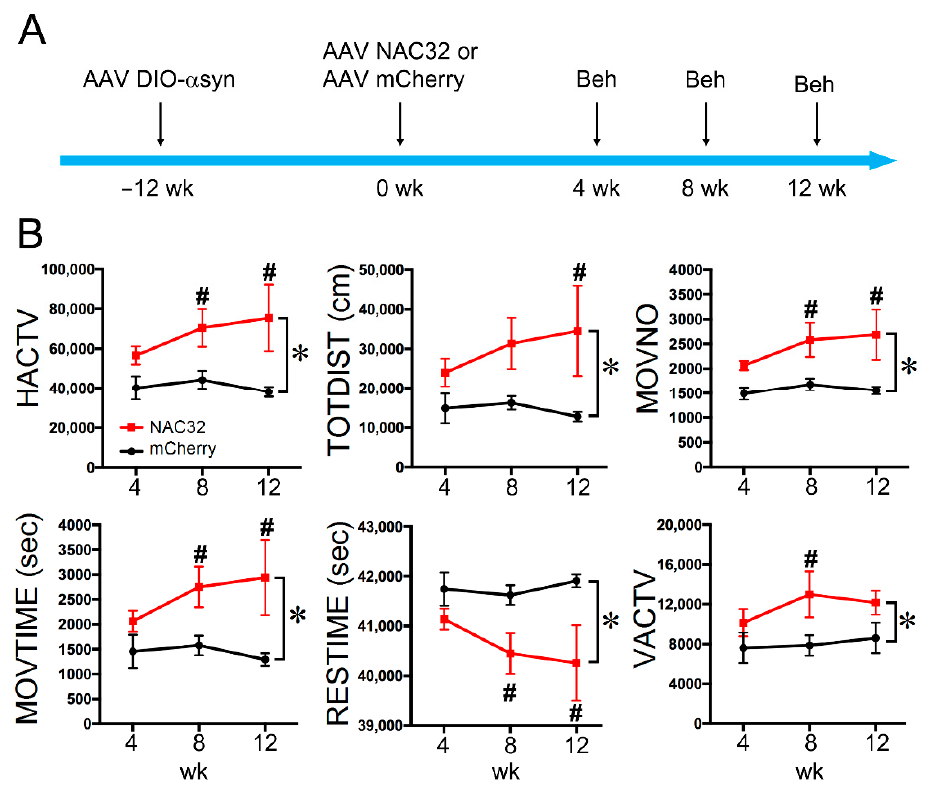
Figure 6. Intranigral administration of AAV-NAC32 normalized locomotor behavior in animals overexpressing α Syn. ( A ) Timeline of experiment. AAV-NAC32 or AAV-mCherry was injected into the SNcd of DAT-Cre rats at time 0. ( B ) Behavioral tests were conducted at 4, 8, and 12 weeks after the viral injection. Animals receiving AAV-NAC32 had a significant improvement in locomotor activity. The significant difference was determined by * two-way ANOVA and # post-hoc NK test. Table 1. Significant improvement in locomotor behaviors after administration of AAV-NAC32 in rats overexpressing α Syn.